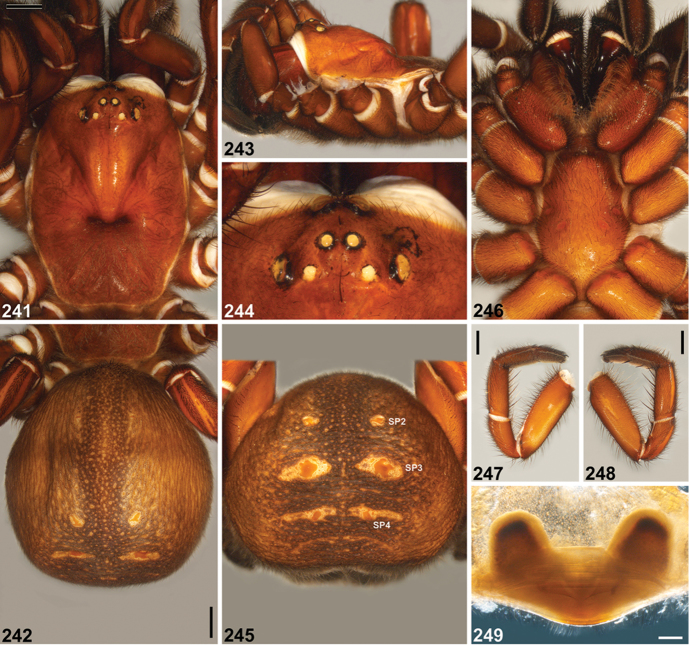

Idiosoma
jarrah sp. n., female paratype (WAM T44390) from Lesmurdie (Western Australia; JAF). 241–242 Carapace and abdomen, dorsal view 243 Carapace, lateral view 244 Eyes, dorsal view 245 Abdomen, posterior view 246 Sternum, ventral view 247 Leg I, prolateral view 248 Leg I, retrolateral view 249 Spermathecae, dorsal view. Scale bars 2.0 (241–242, 247–248), 0.5 (249). SP2–4 = sigilla pairs 2–4.